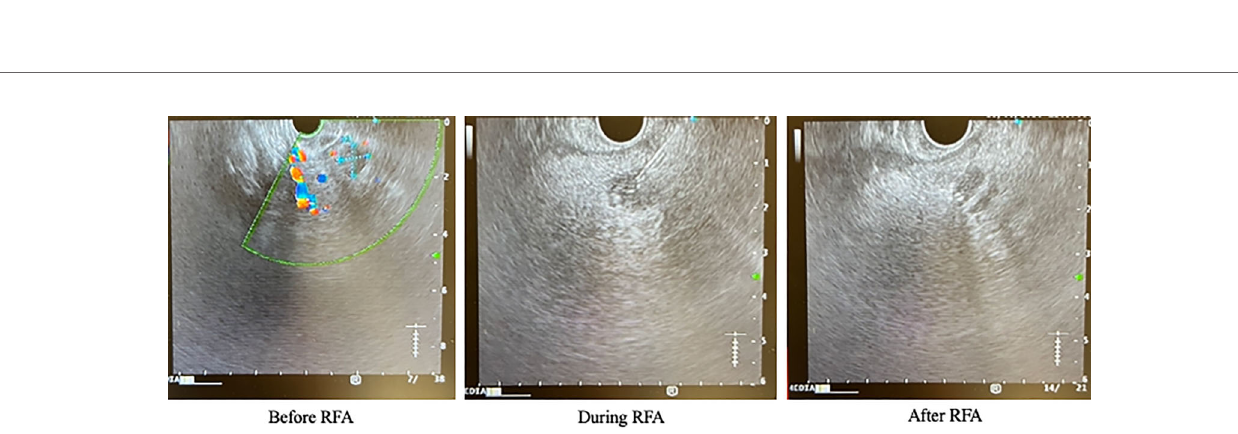
Frontiers in Endocrinology |